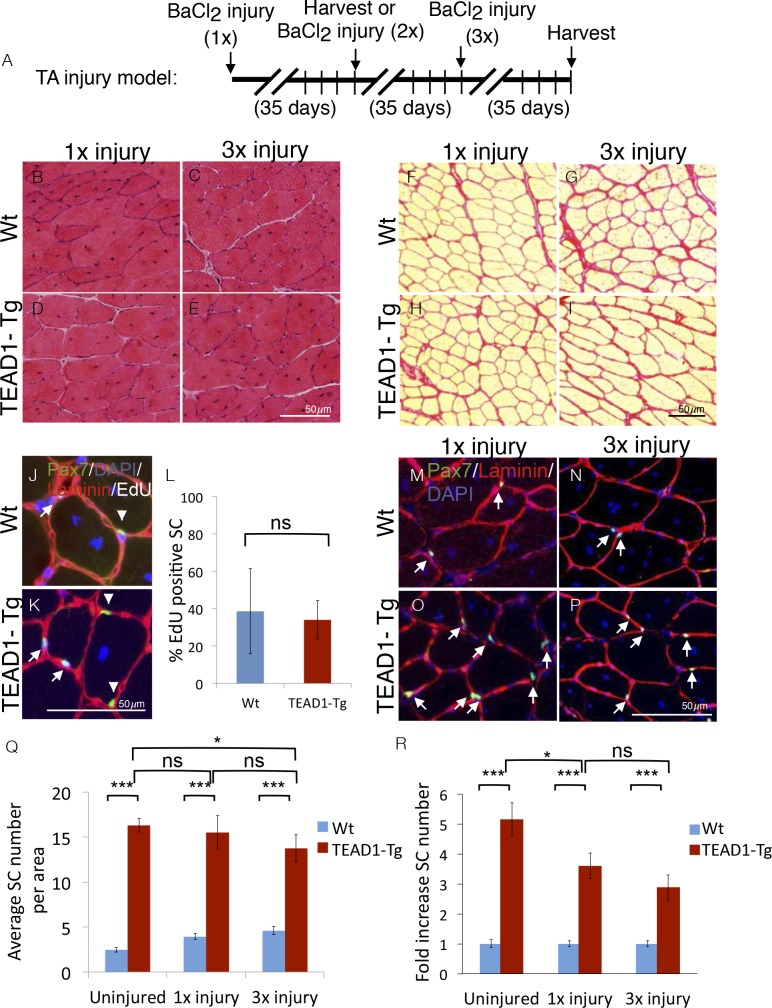
SC hyperplasia persists through multiple injuries.Adult mouse TA muscles were injured with BaCl2 multiple times with 35-day regeneration periods between injuries as indicated (A). This injury paradigm applies to panels B–I, M–P) H and E stains show muscle after 35 days of regeneration following one injury (B,D) or 3 injuries (C,E) for Wt (B,C) or TEAD1-Tg muscle (D,E). (F–I) Sirius Red stains show the connective tissue after 35 days of regeneration following one injury (F,H) or 3 injuries (G,I) for Wt (F,G) or TEAD1-Tg muscle (H,I). (J–L) Wt (J) and TEAD1-Tg (K) TA muscles were injured with CTX and regenerated for 2 weeks. EdU was given on days 2–5 of regeneration. IF of Pax7 (green), laminin (red), EdU (white), and counterstained with DAPI (blue) allowed for quantification of sublaminal Pax7 and EdU positive cells (L). Myonuclei in images are EdU positive but reduced in intensity due to larger nuclear volume. M–P) Numbers of Pax7 expressing cells were assessed by IF of Pax7 (green) and laminin (red), counterstained with DAPI (blue) after 35 days of regeneration following one injury (M,O) or 3 injuries (N,P) for Wt (M,N) or TEAD1-Tg muscle (O,P) and is quantified as SC averages per area (Q) and fold increase relative to Wt (R). Uninjured data from Figure 2 displayed for comparison. n > 3 adult mice for all measurements, p<0.05 represented by (*), p<0.005 represented by (**), p<0.0005 represented by (***).